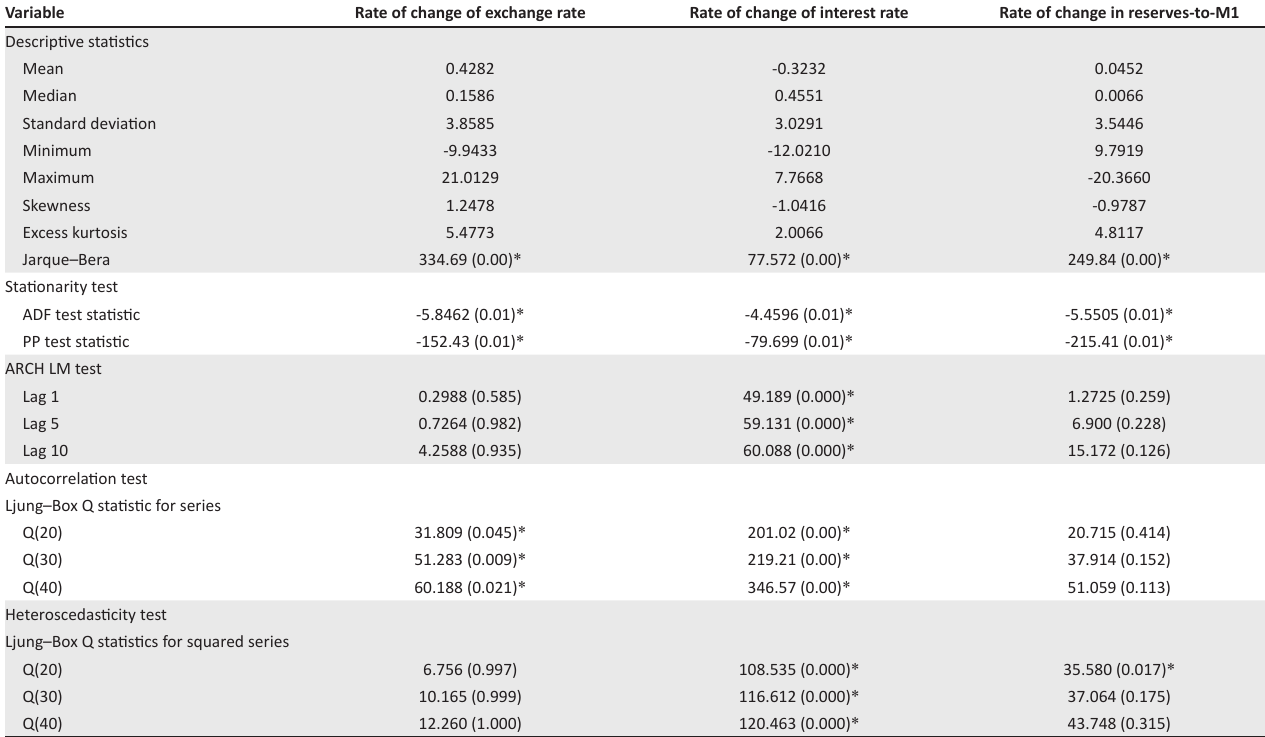
TABLE 1: South African descriptive statistics and time series tests of components of exchange market pressure.